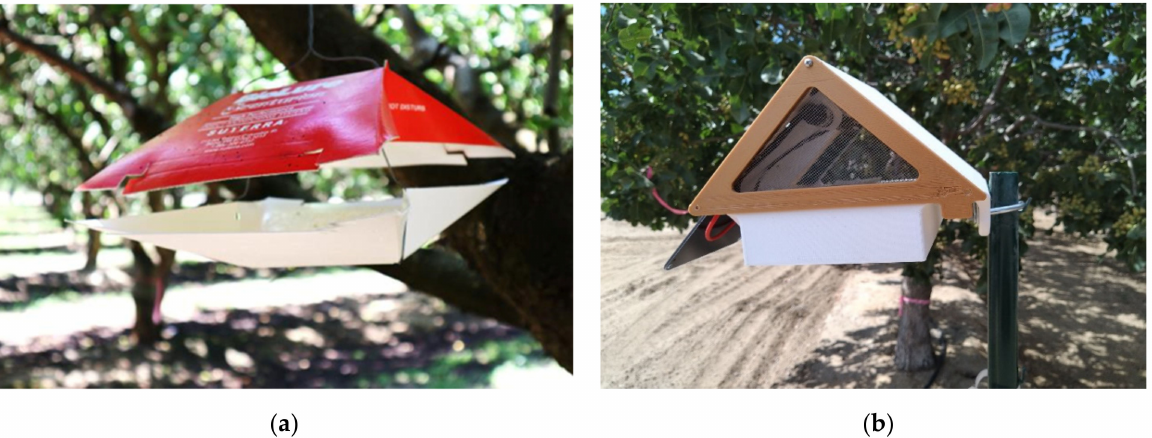
Figure 1. Monitoring devices used in the current study: ( a ) A conventional sticky trap with a glue-lined lower liner (other descriptions of sticky traps can be found in references [7,14,22]); ( b ) A pseudoacoustic optical sensor trap deployed in a pistachio orchard. Infrared sensors inside the frame on the opposite side of the trap detect wing frequency from navel orangeworm adults drawn into the device by attractants. The sensor communicates with a server via a cellular SIM card and frequencies unique to navel orangeworm are identified on the server by machine learning